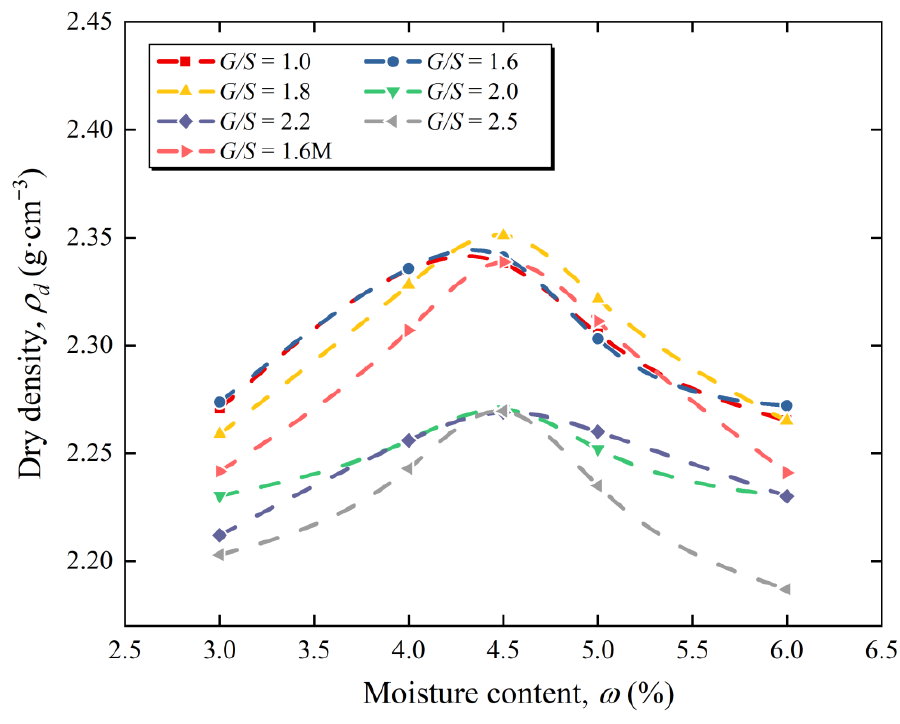
Figure 4. Proctor compaction curves of UPAB specimens with 7 designed gradations. Table 2. Results of laboratory proctor compaction